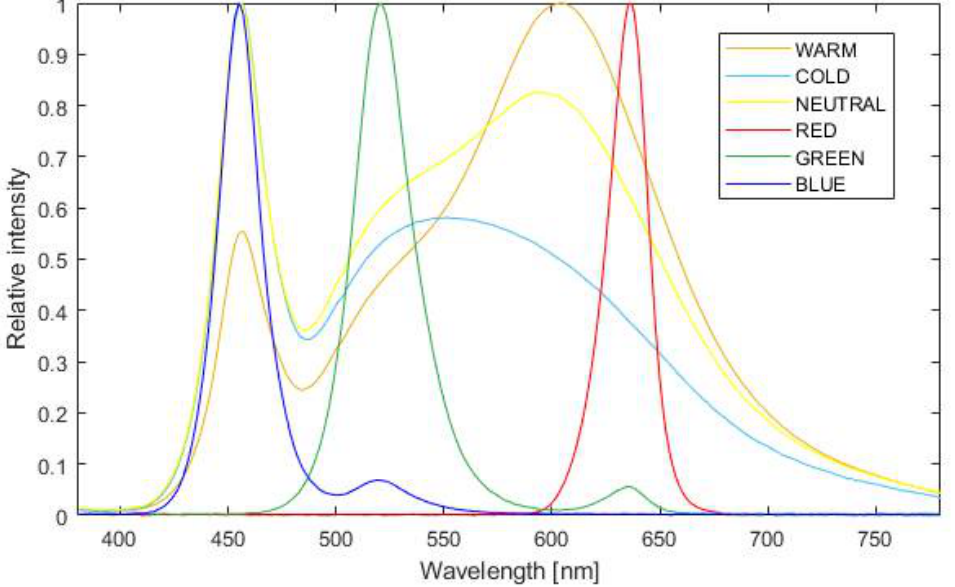
Figure 7. Spectral specification of the LED light sources. Table 3. Photometric values of the LED light sources.